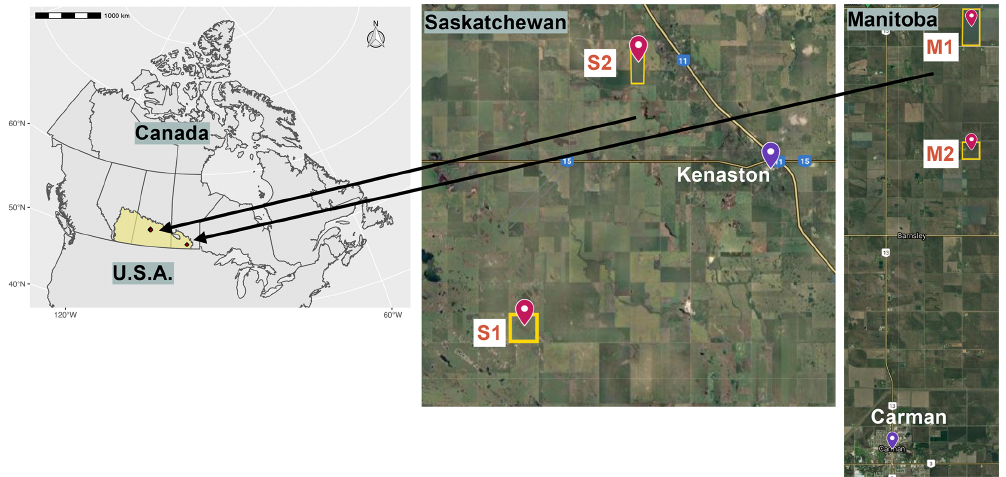
Figure 1. Locations of the four study farms in Saskatchewan (S1 and S2), near Kenaston, and in Manitoba (M1 and M2), near Carman (© Google Earth 2021). Table 2. Information about each of the four study sites (data from 2015 to 2019). Study Lat Long Area P ( mm ) P ( mm ) P /PET site ( ha ) 1 Apr–31 Oct annual ( mmd − 1 ) S1 51.42335 − 106 . 46100 263